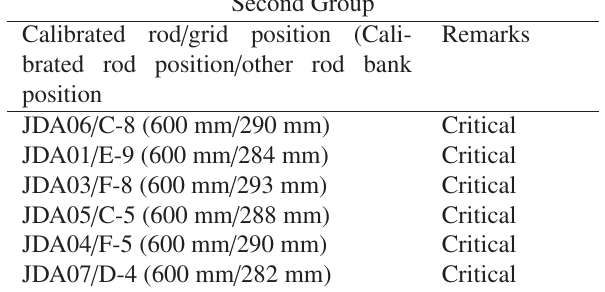
Table 4. Prompt neutron generation time for di ff erent nuclear